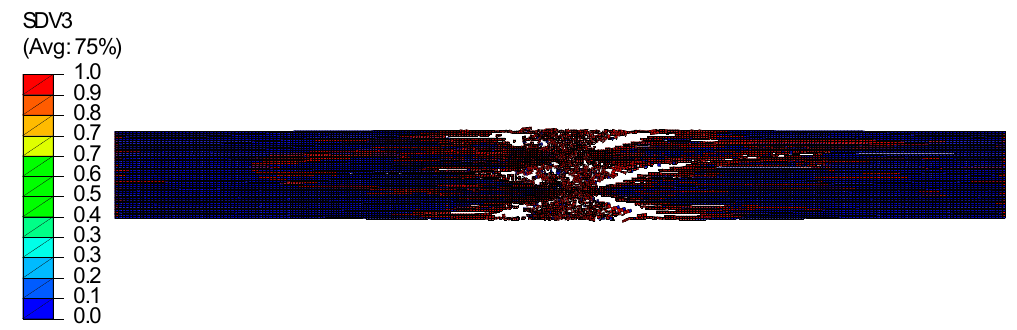
Figure 11. Matrix tensile failure nephogram.